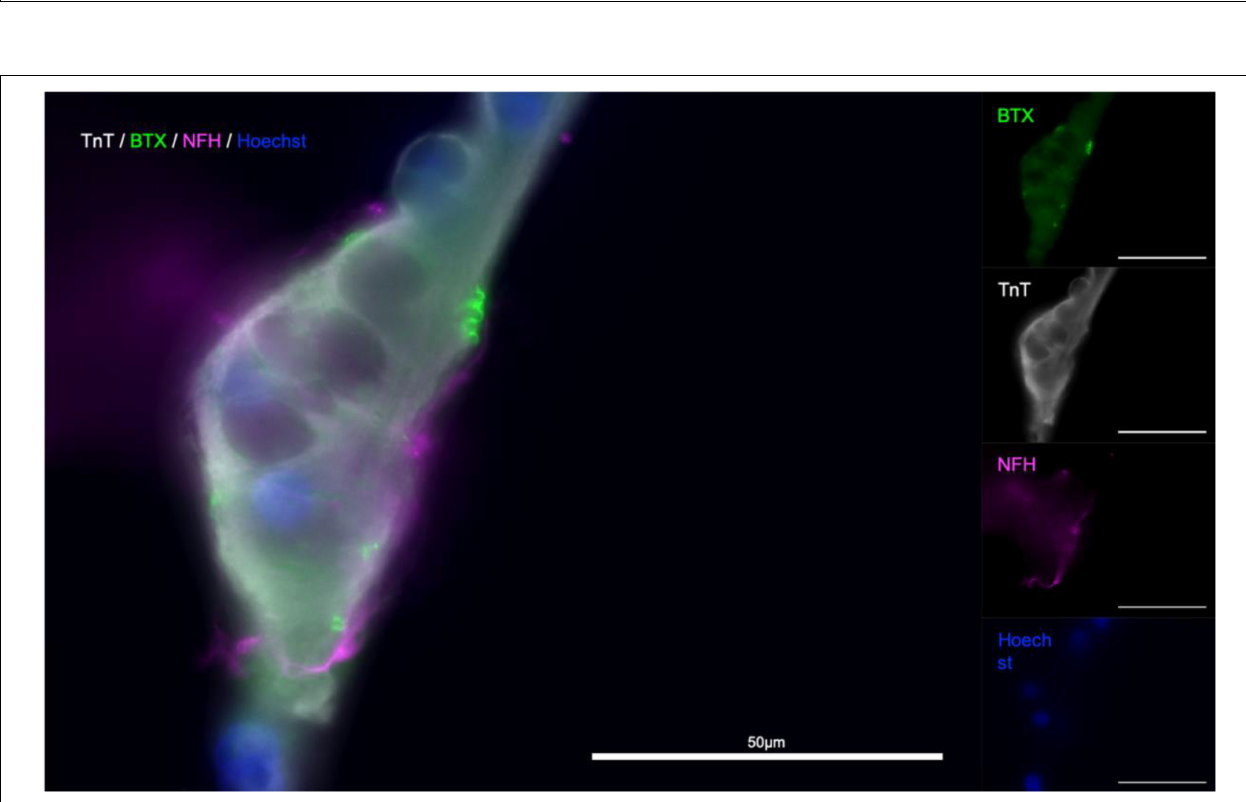
Frontiers in Integrative Neuroscience |